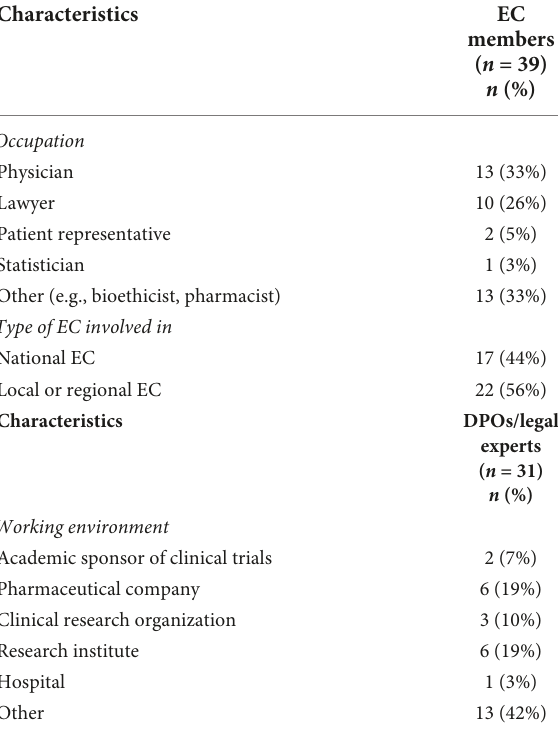
TABLE 2 Characteristics of EC members and DPOs/legal experts.